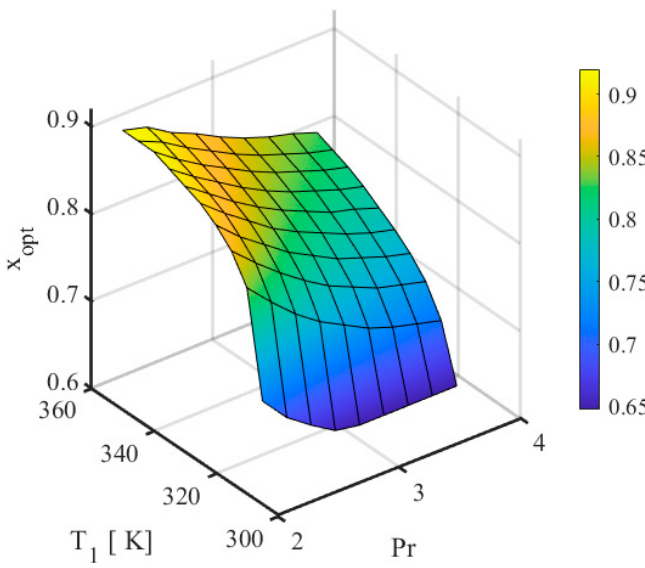
Figure 13. Deviation of x with (cid:1846) (cid:2869) and cycle overall pressure ratio ((cid:1842)(cid:1870)) .